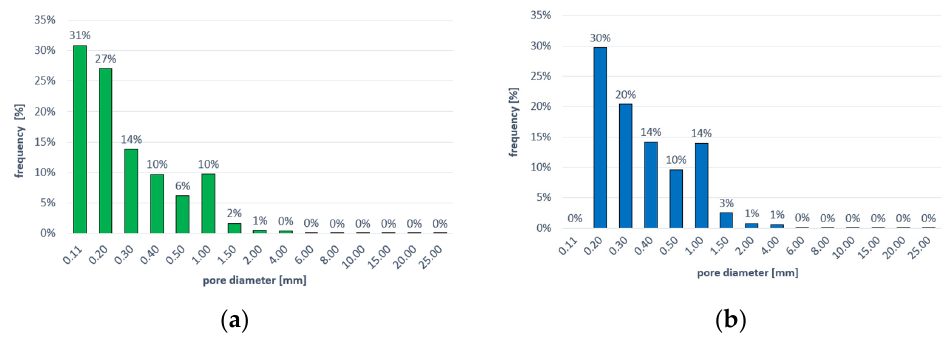
Figure 10. Frequency of pores with different diameters: ( a ) for C-C series concrete, ( b ) for C-RA series concrete.